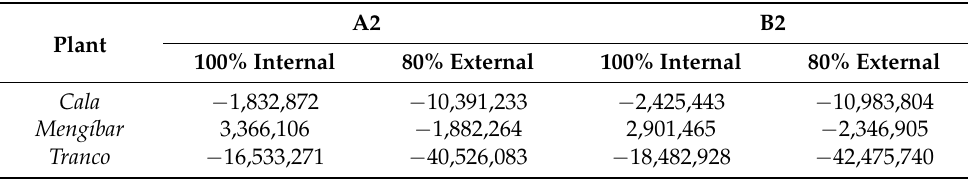
Table 9. Net present values of investments in pilot centers, A2 and B2